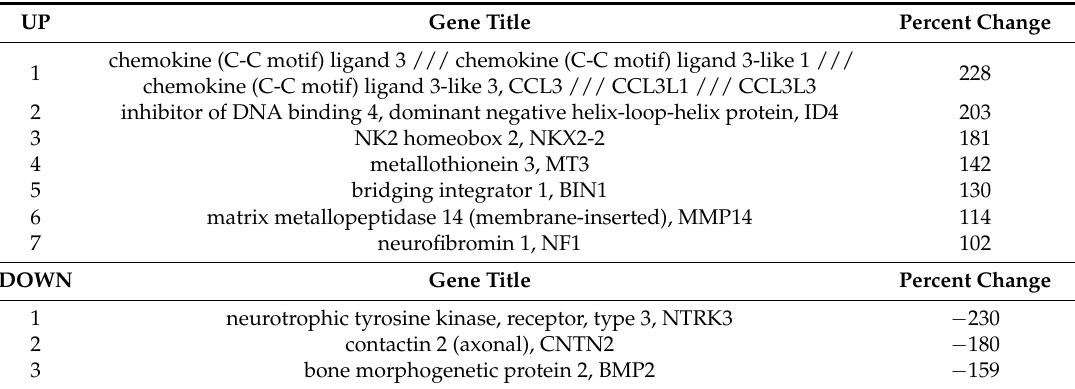
Table 18. GHK and Genes Associated with Astrocytes.